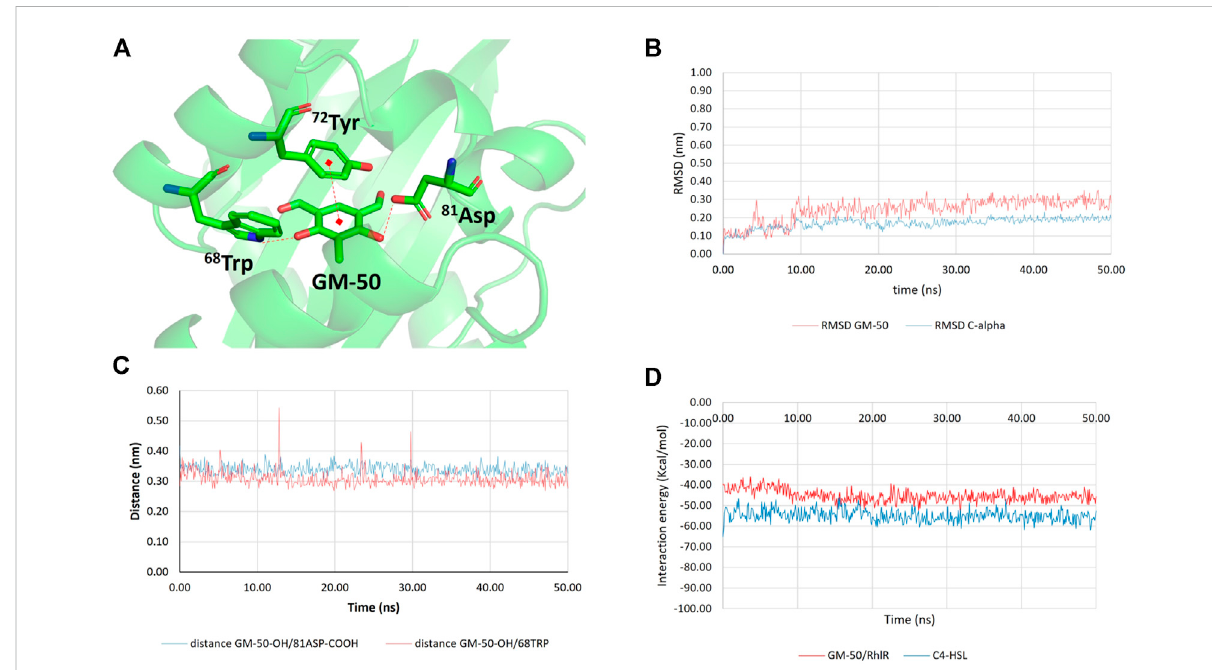
FIGURE 8 Results of molecular docking and molecular dynamics simulations between GM-50 and RhlR. (A) Predicted interactions between GM-50 and RhlR. H-bonds and π - π interactions are depicted as dashed red lines. (B) Root-mean squared deviation (RMSD) values for the protein C-alpha atoms (blue line) and GM-50 (displacement of ligand heavy atoms with respect to protein C-alpha atoms; red line). (C) Time dependent distance between GM-50 phenolic function and 81Asp sidechain (blue line) and between GM-50 phenolic function and 68Trp indole NH (red line). Both the distances arecompatible withstable H-bonds. (D) Timedependentinteraction energies (Kcal/mol) betweenGM-50andRhlR(redline)andbetween C4HSL and RhlR (blue